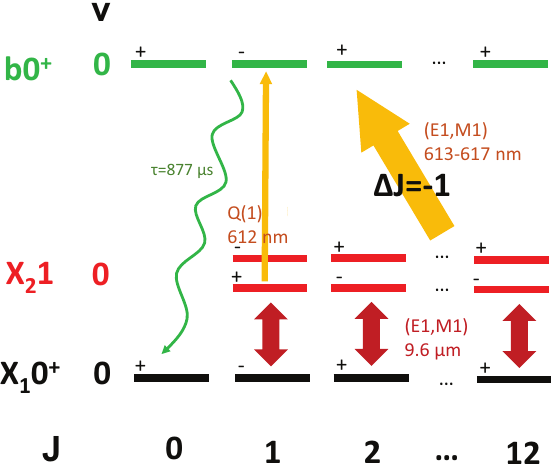
Figure 4. Rotational cooling scheme using X → b0 + at 600 nm. Straight arrows show transitions driven by lasers, with arrow width indicating laser linewidth. Both the X 1 0 + − X 2 1 coupling and the X 2 1 → b0 + lasers are capable of driving M1 transitions that preserve parity. The wavy arrow indicates the spontaneous emission channel to the dark